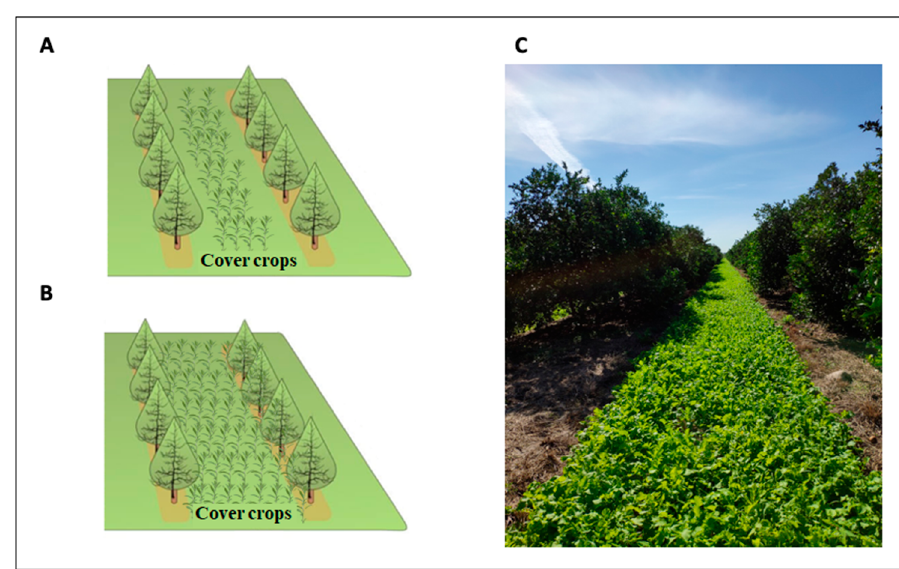
Figure 2. Cover crops can be planted in the inter-row middles ( A ) or between trees ( B ) in perennial systems. In warmer climates, such as in Florida for citrus, year-round cover crop planting is possible for perennial systems ( C ).